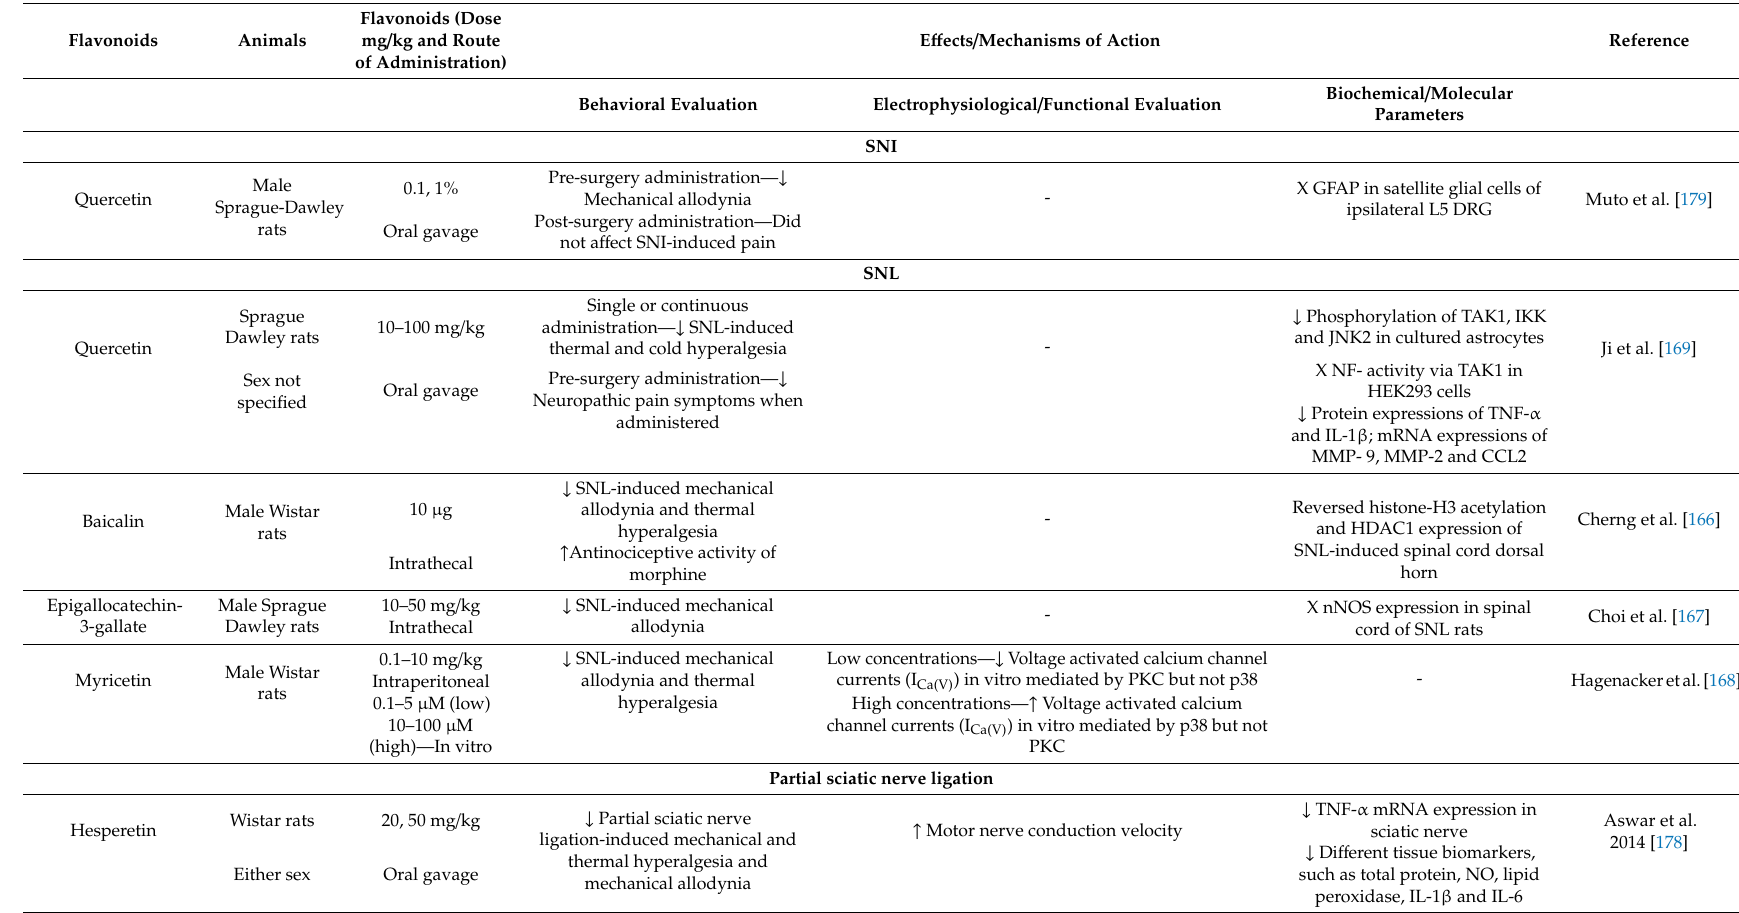
Table 6. E ff ects of flavonoids on other peripheral neuropathic pain